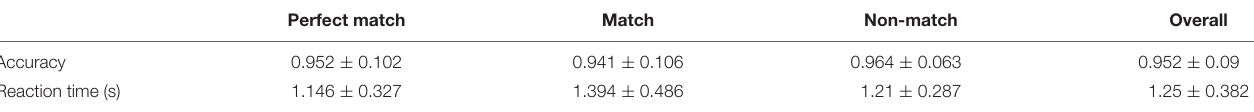
FIGURE 3 | Experimental procedure. A 30 s long-baseline recording was followed by a 0.5 s long fixation point shown in the center of the computer screen. After turning off the fixation point, subjects saw a randomly chosen jigsaw puzzle piece, followed by 0.75 s long white noise masking image. Subsequently, the puzzle template was shown on the screen for 3 s during which the subjects had to give a “Yes” (“Matched”) or “No” (“Unmatched”) answer. Another 0.75 s long white noise masking image was followed by an inter-stimulus interval randomly chosen from the range of 9–12 s. TABLE 2 | Summary of the behavioral data in mean ± standard error. Perfect match Match Non-match